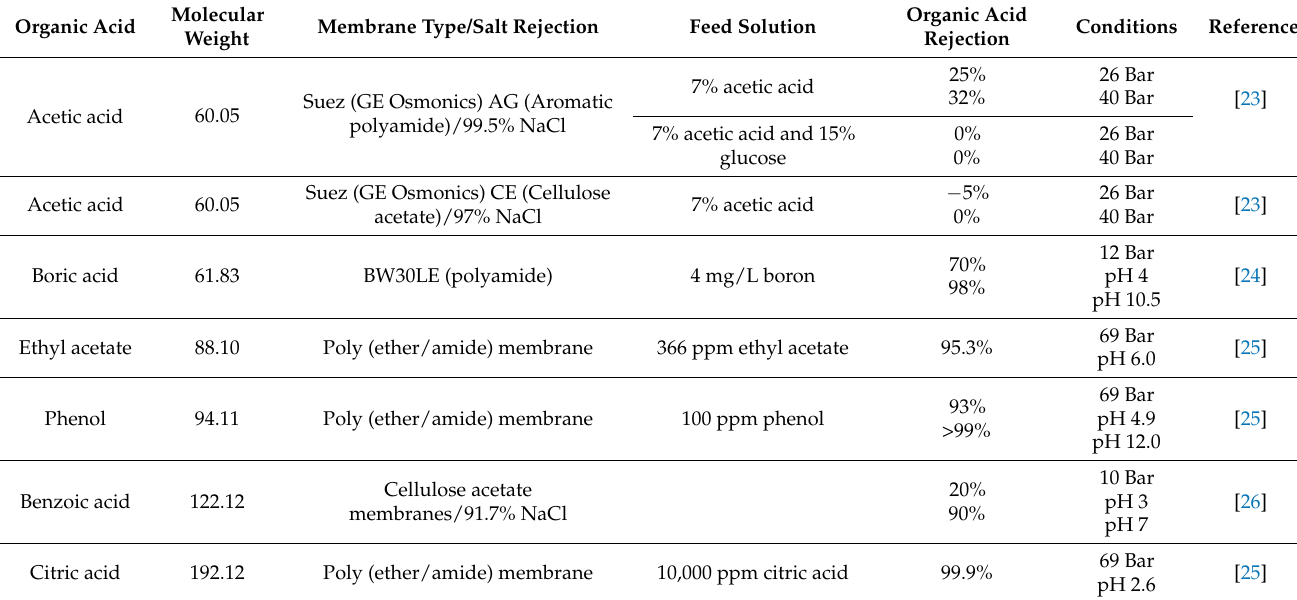
Table 1. Separation of different organic acids using reverse osmosis